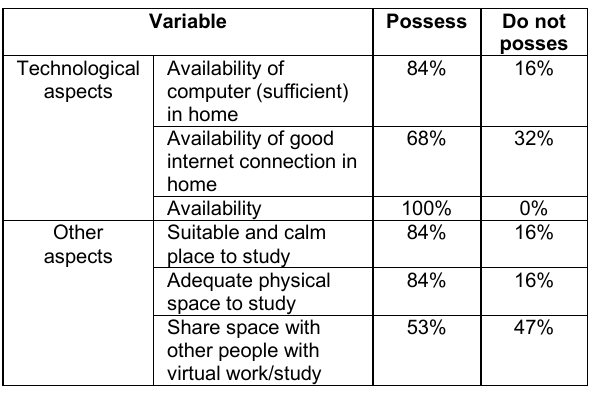
Table 4. Technological disparity in students in virtual learning